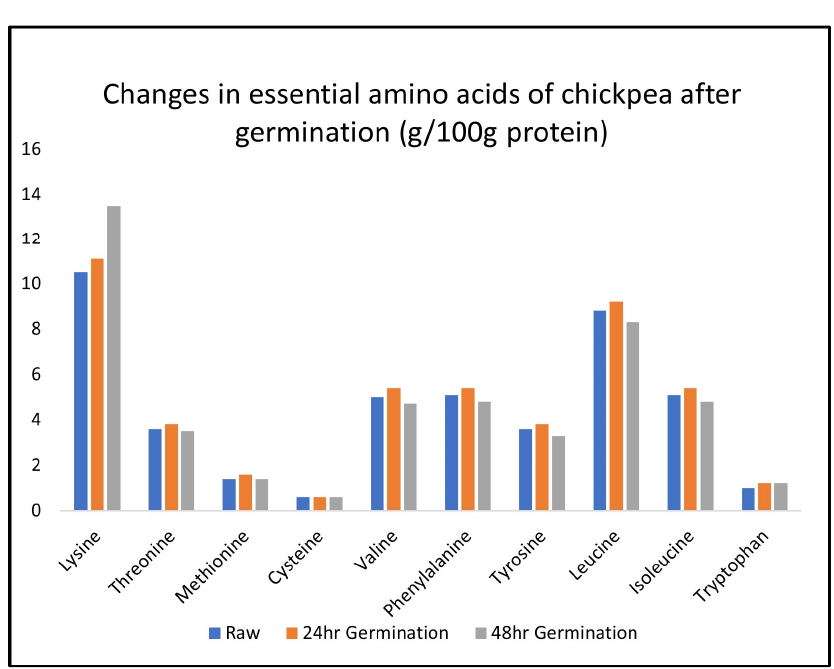
Figure 2. Changes in essential amino acid content in chickpea after germination [61].